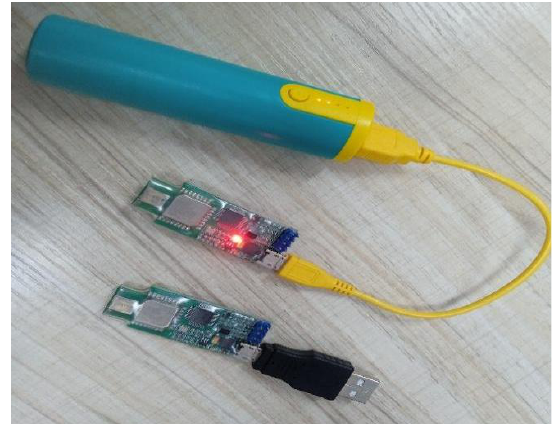
Figure 10. The ultra-wideband (UWB) node is connected with the power supply .